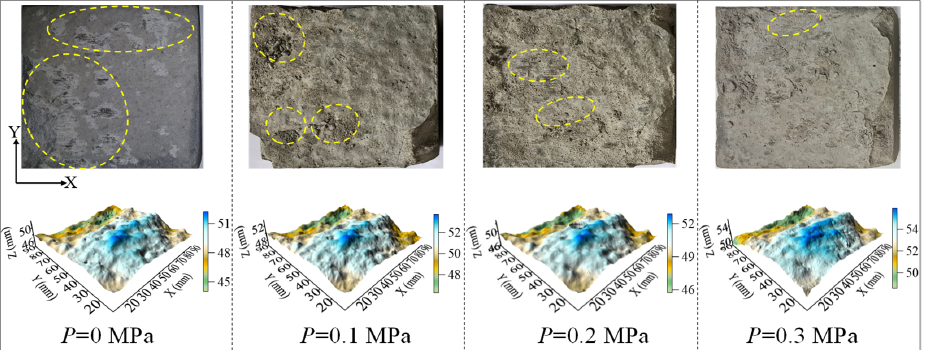
Figure 5. Failure of the structural plane.